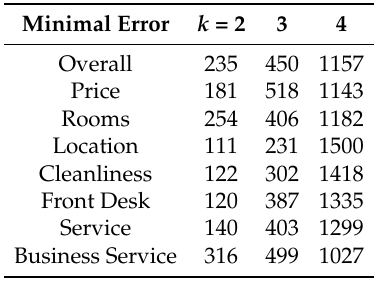
Table 12. Number of times each k minimizes flooring error.